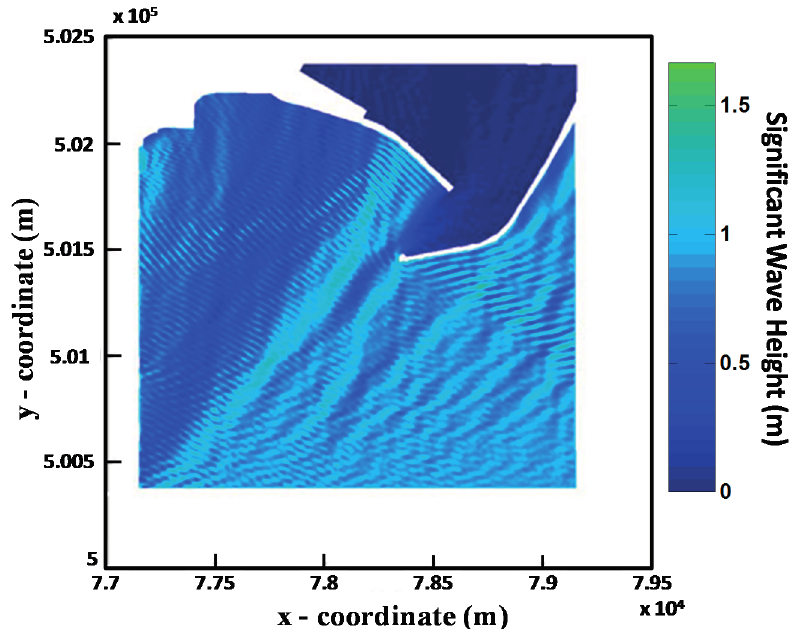
Figure 12. Wave field simulation of the Salerno Harbour obtained through the Mild Slope